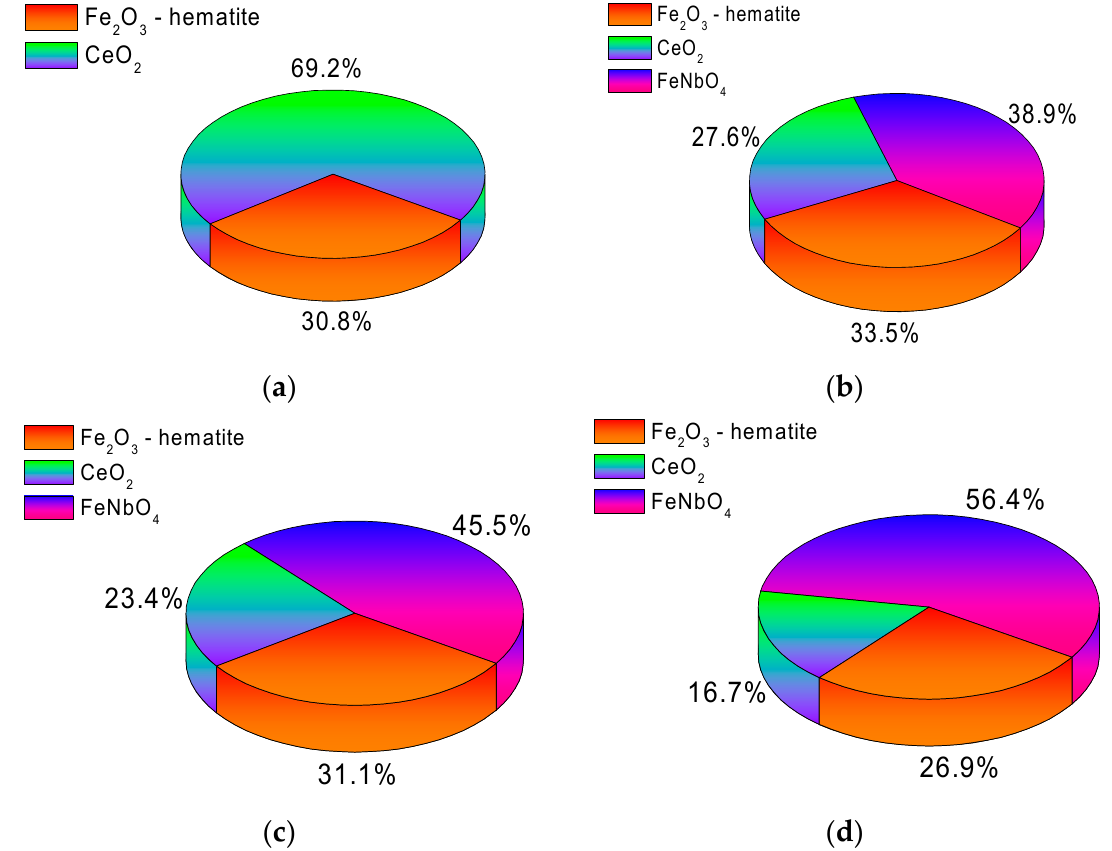
Figure 5. Phase analysis data obtained by analyzing X-ray diffractograms: ( a ) FeCeO x nanoparticles; ( b ) 0.9FeCeO x + 0.1Nb 2 O 5 nanoparticles; ( c ) 0.8FeCeO x + 0.2 Nb 2 O 5 nanoparticles; and d ) 0.7FeCeO x